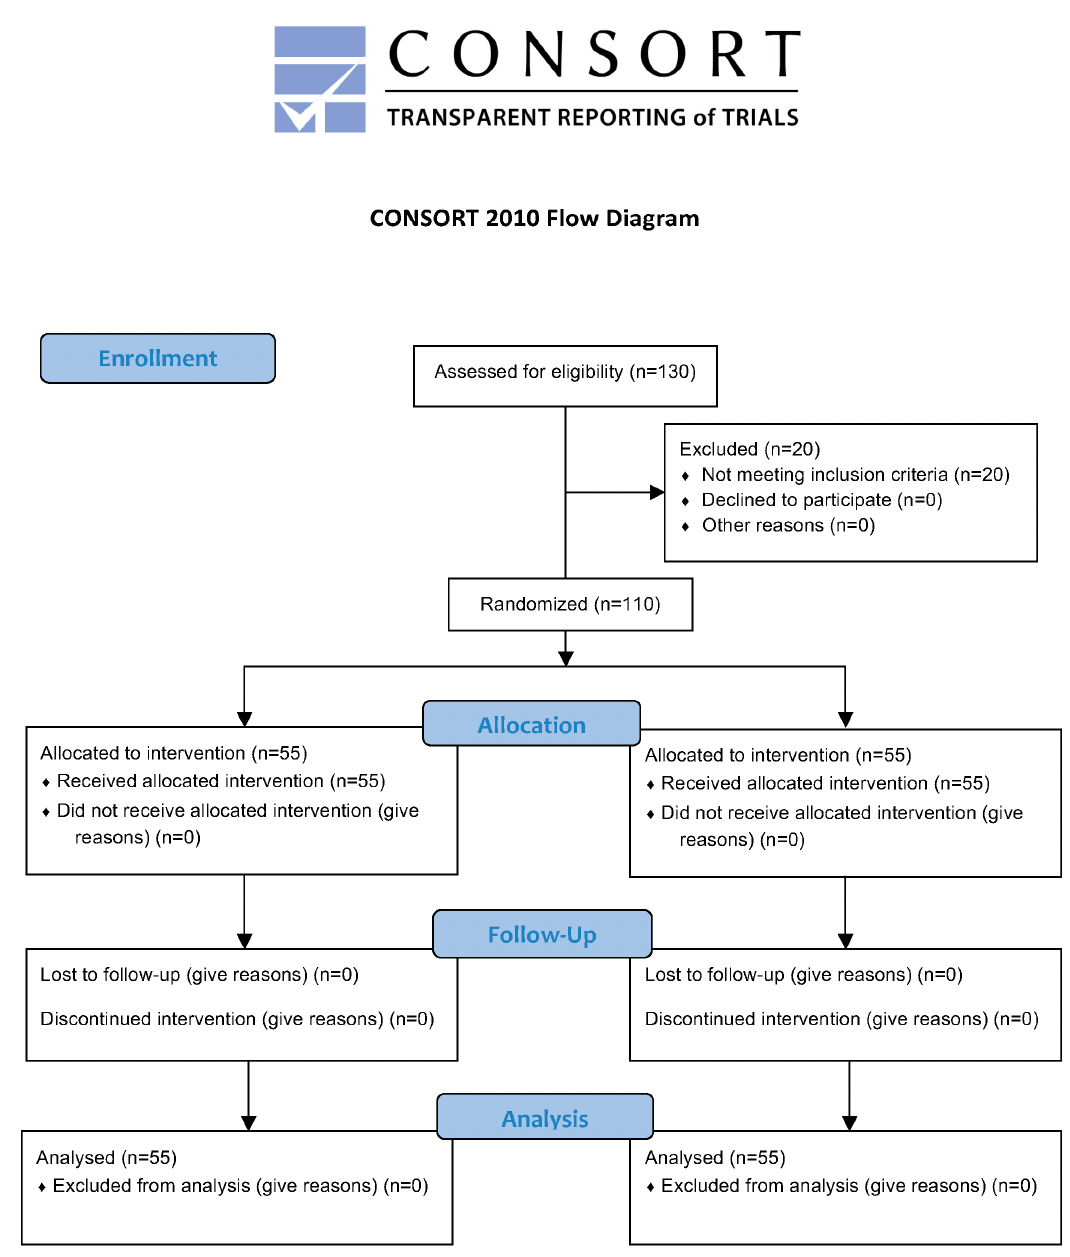
Figure 4. Consort flow diagram.